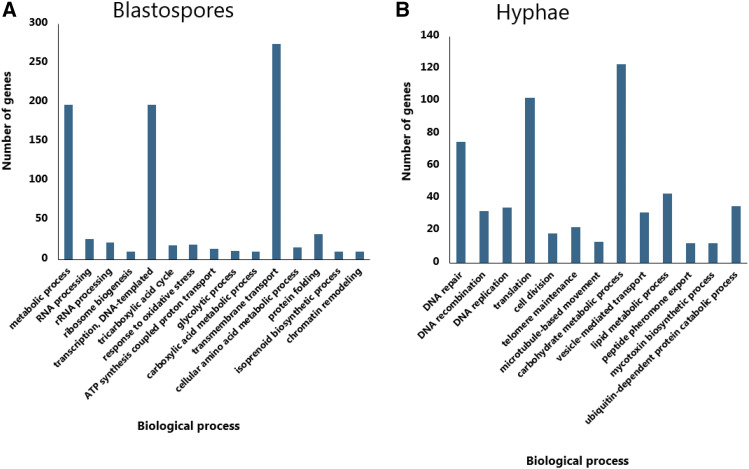
Enriched gene ontology (GO) terms for the biological process category based on GSEA analysis (See text for details) in blastospores (5a) and hyphae (5b) (FDR- p-value < 0.25) (Additional file 4).